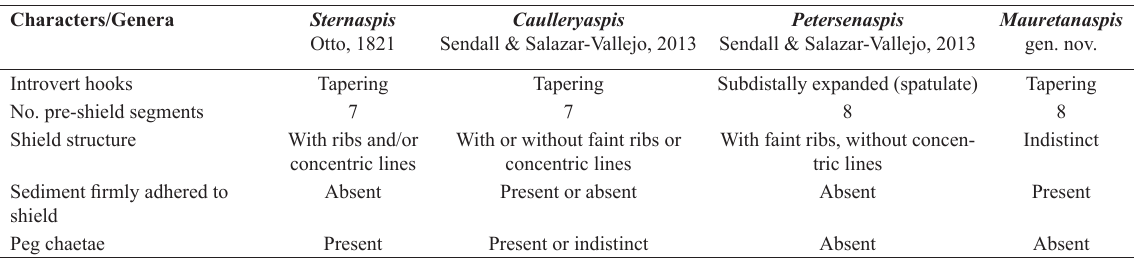
Table 2. Distinctive characters of sternaspid genera (modified after Salazar-Vallejo 2017).